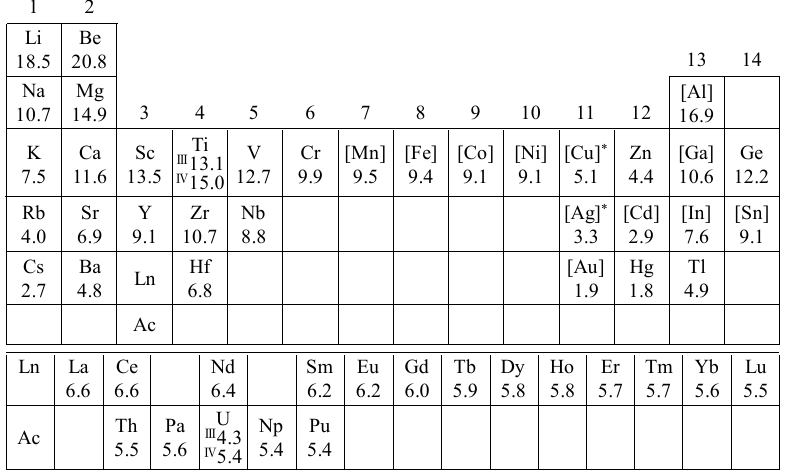
) and hydrogen density in M (BH 4 n